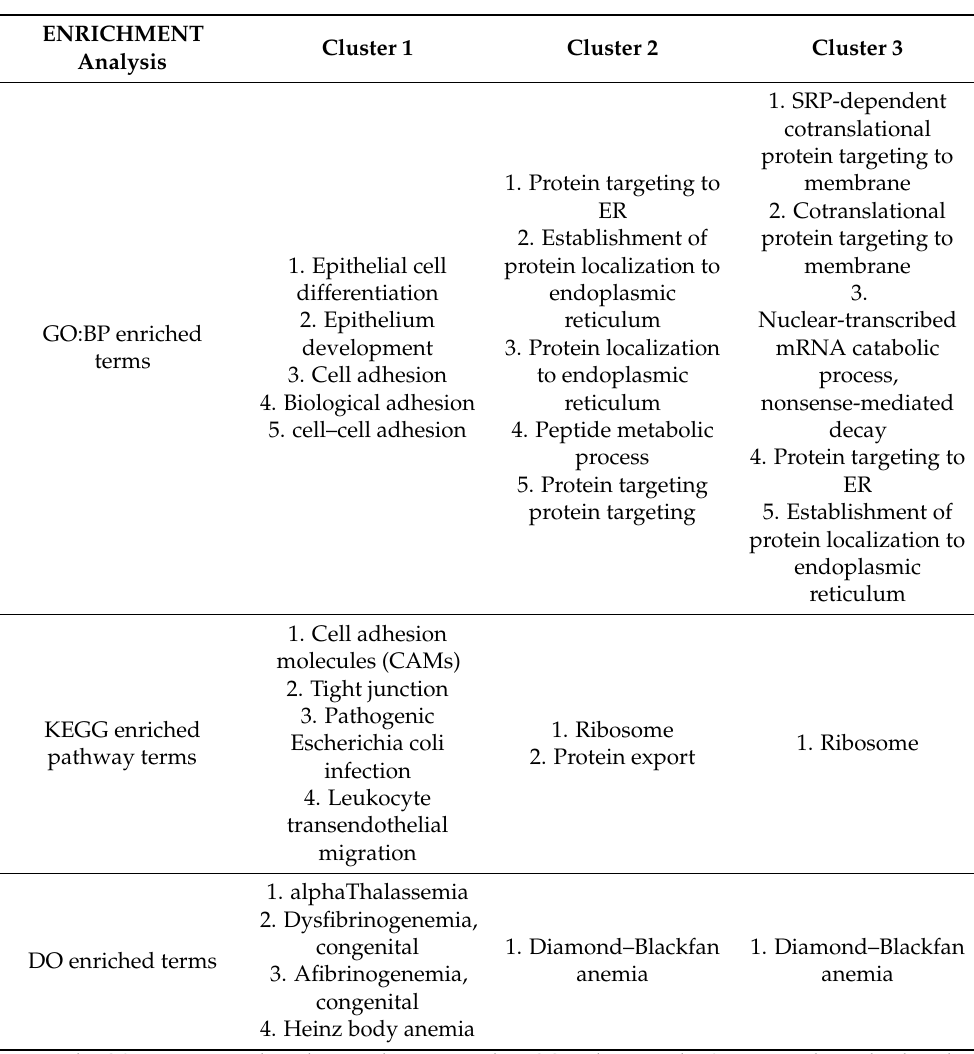
Table 7. GO: BP, KEGG pathway, DO enriched terms for the identified